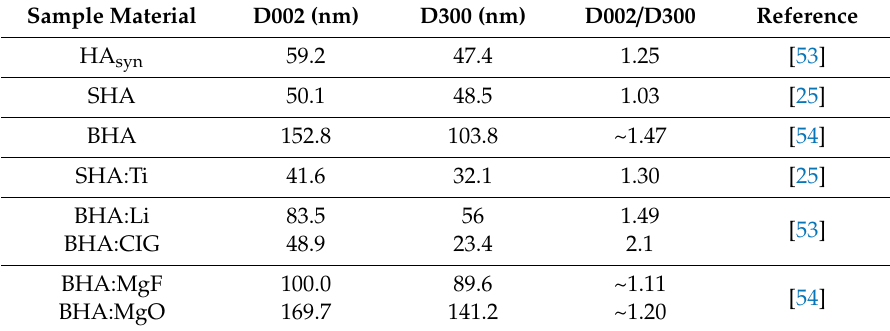
Table 2. Crystalline coherence length in the case of BioHA coatings synthesized by PLD, function of doping materials. Determinations were performed along the c -axis [(002) crystal plane] and a -axis [(300) crystal plane] by applying the Scherrer